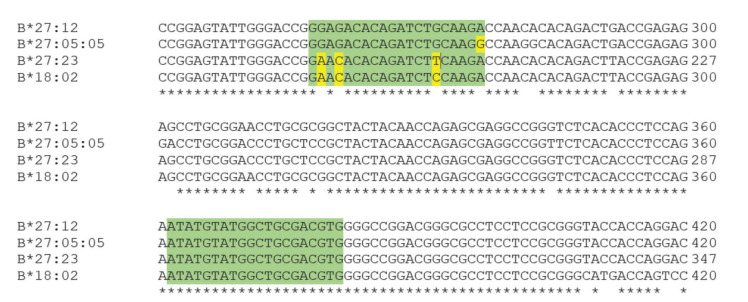
Clustal Omega multiple sequence alignment from the PCR-amplified regions of HLA-B*27:12, B*27:05:05, B*27:23, and B*18:02. The binding sites of mix 12 primer pairs are highlighted in green. The yellow highlights indicate the divergent nucleotides.